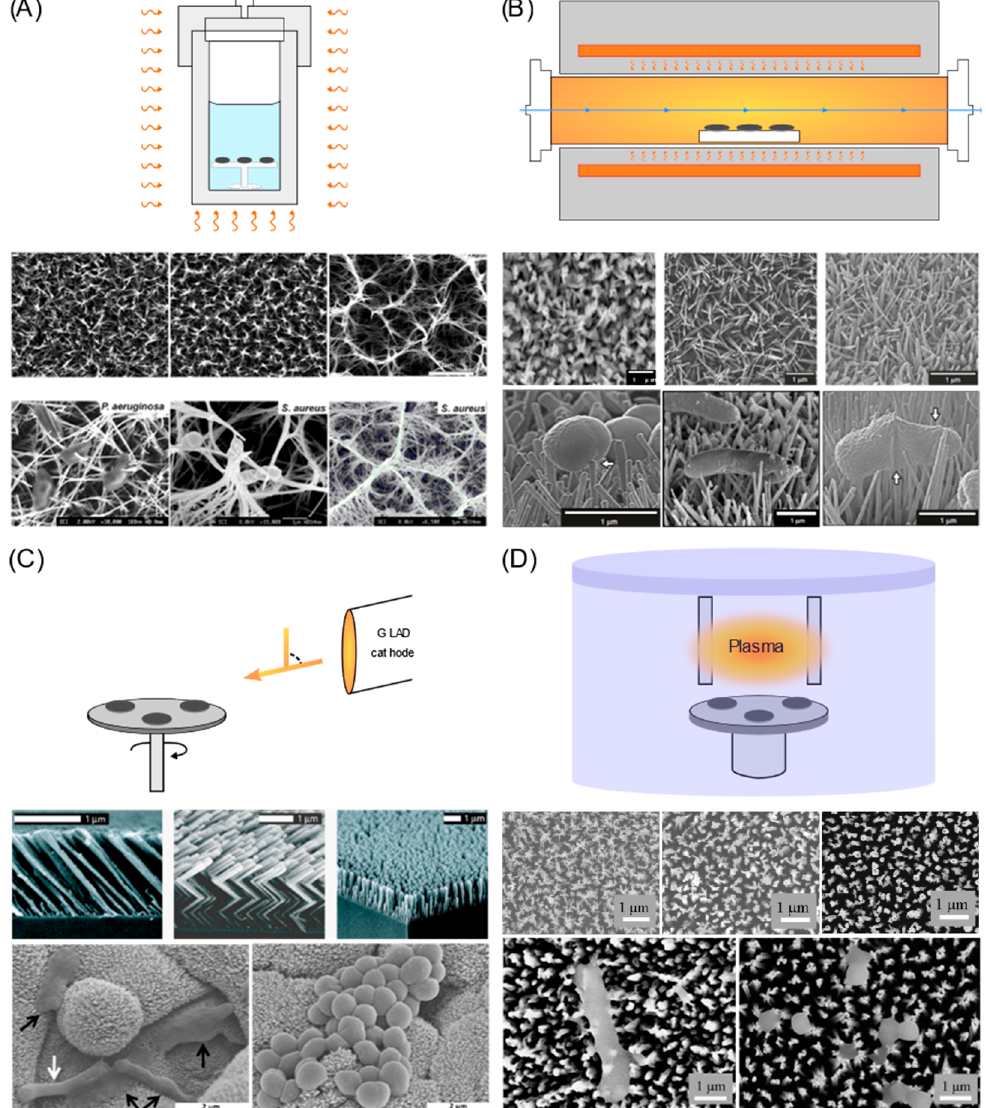
Figure 4. Nanofabrication techniques that offer excellent versatility and high throughput and the typical surface topographies generated: ( A ) alkaline hydrothermal (AH); ( B ) thermal oxidation (TO); ( C ) glancing angle deposition (GLAD) and ( D ) reactive ion etching (RIE). Each panel shows a basic schematic of the technique, an example of the protruding nanostructured surfaces generated by each technique and evidence of bactericidal activity.